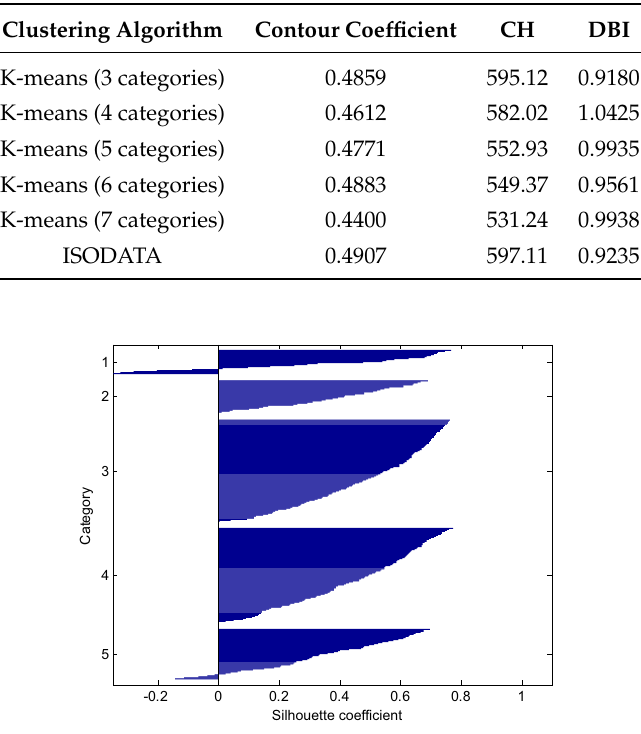
Figure 8. The silhouette coefficient of ISODATA